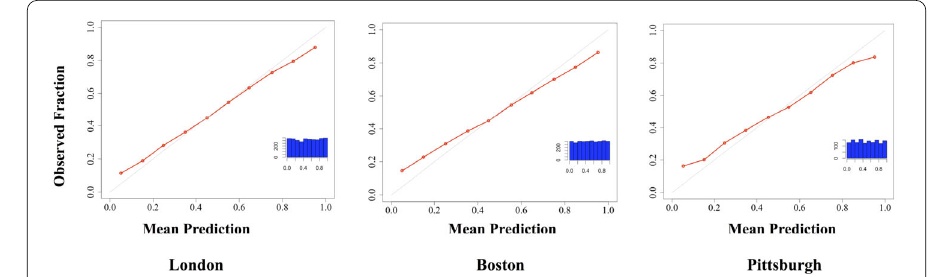
Figure 3 Reliability curves of the biking risk model probabilistic predictions